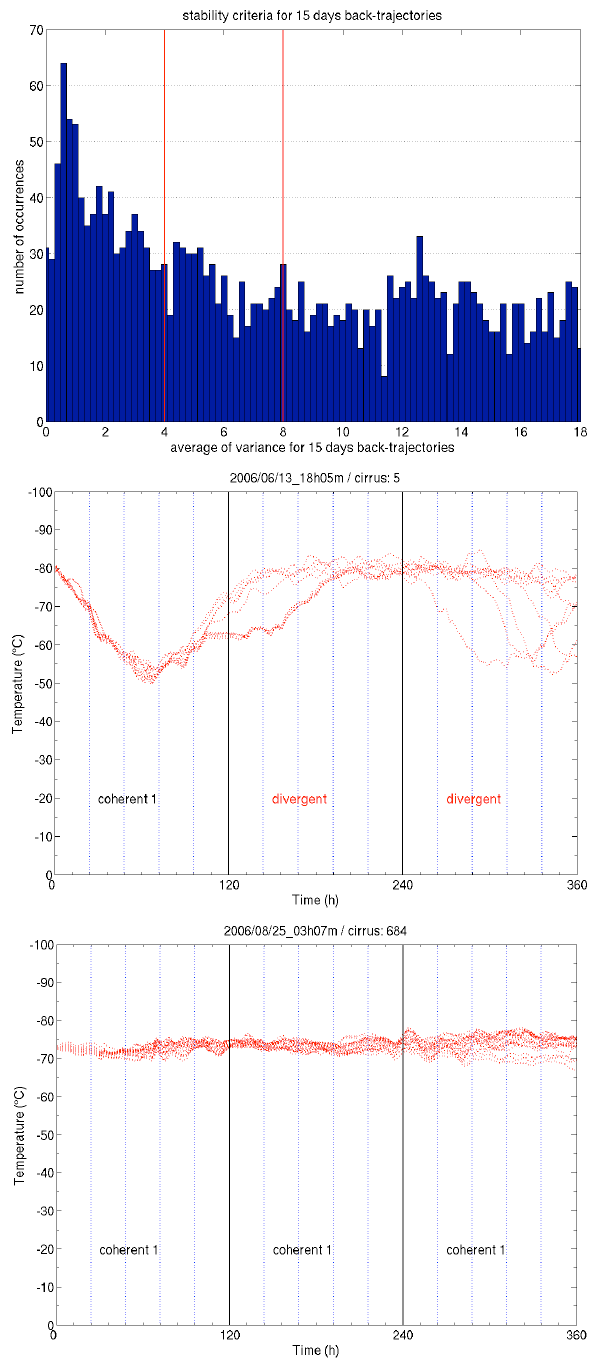
Fig. 5. (a) Histogram of temperature variance for 15 days back- trajectories for each SVC over 3yr of data. Red lines represent the 3 different classifications. (b, c) Example of temperature histories across 15-days. The temperature coherence criterion is applied on 5-days